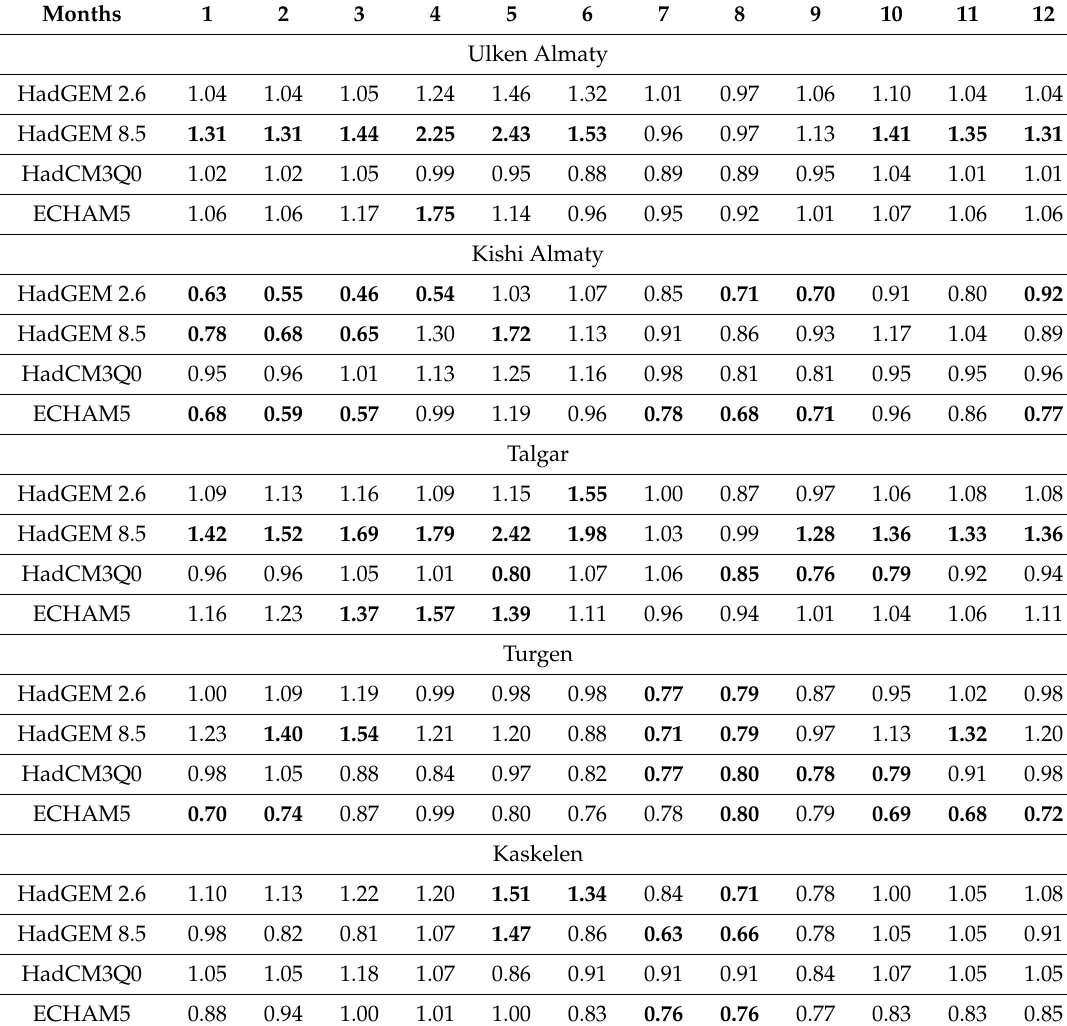
Table6. Projectedchangesinmonthlystreamflowin2076–2095relativetothebaselineperiod(1985 / 1986– 2004 / 2005). Changes exceeding one standard deviation in the observed streamflow during the baseline period are highlighted in